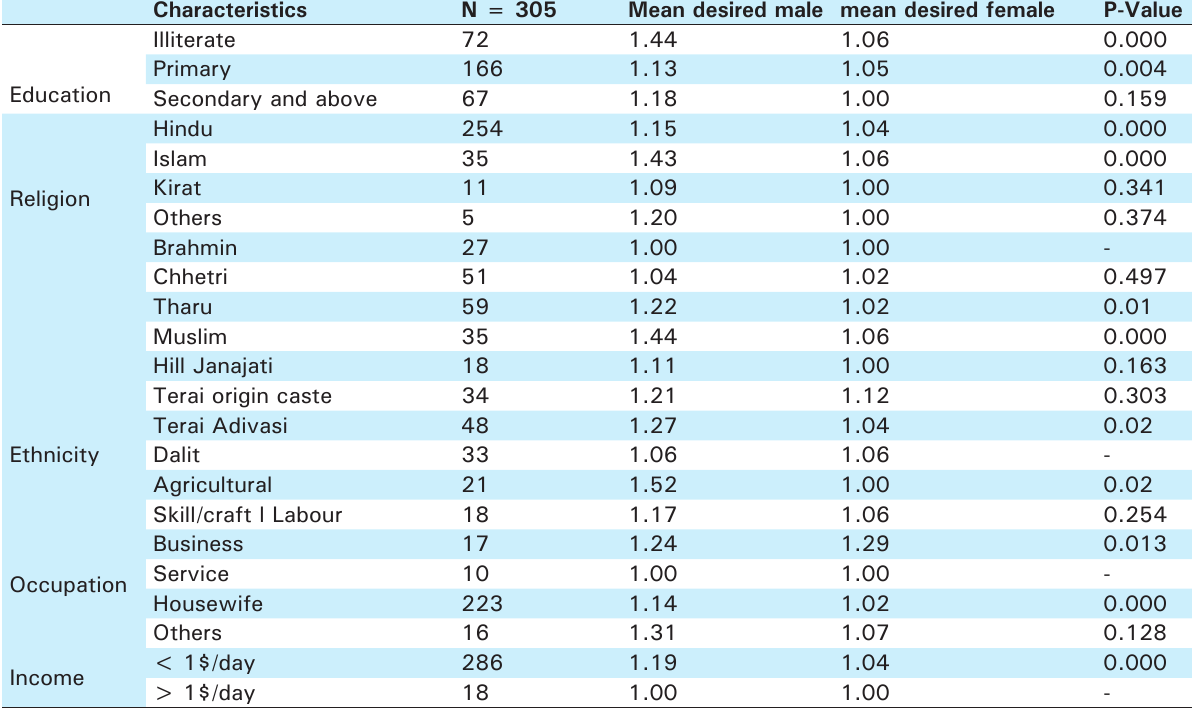
Table No. 4. Females proceeding to next child by gender of the previous